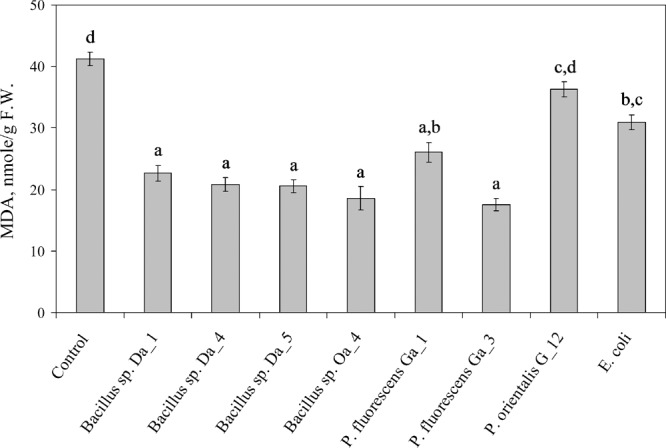
Accumulation of MDA in the leaves of apple shoots co-cultivated with endophytic bacteria. Apple shoots were inoculated with 3 μL of each strain suspended at ∼107 cfu/ml in (MS) medium and observations were made after 1 week. Data are presented as the mean and SEM of at least three repeats from three independent experiments. Means followed by the same letter are not significantly different (p < 0.05).